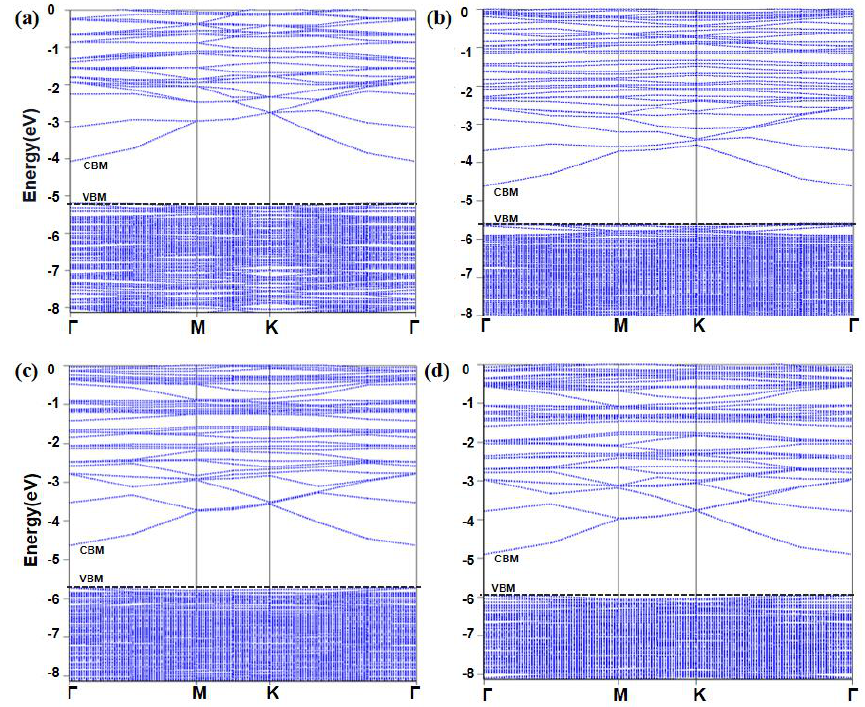
Figure 3. Band structures of 001 perfect surface ( a ), V O ( b ), V Sn ( c ), V Zn ( d ). The dotted line is the Fermi level.